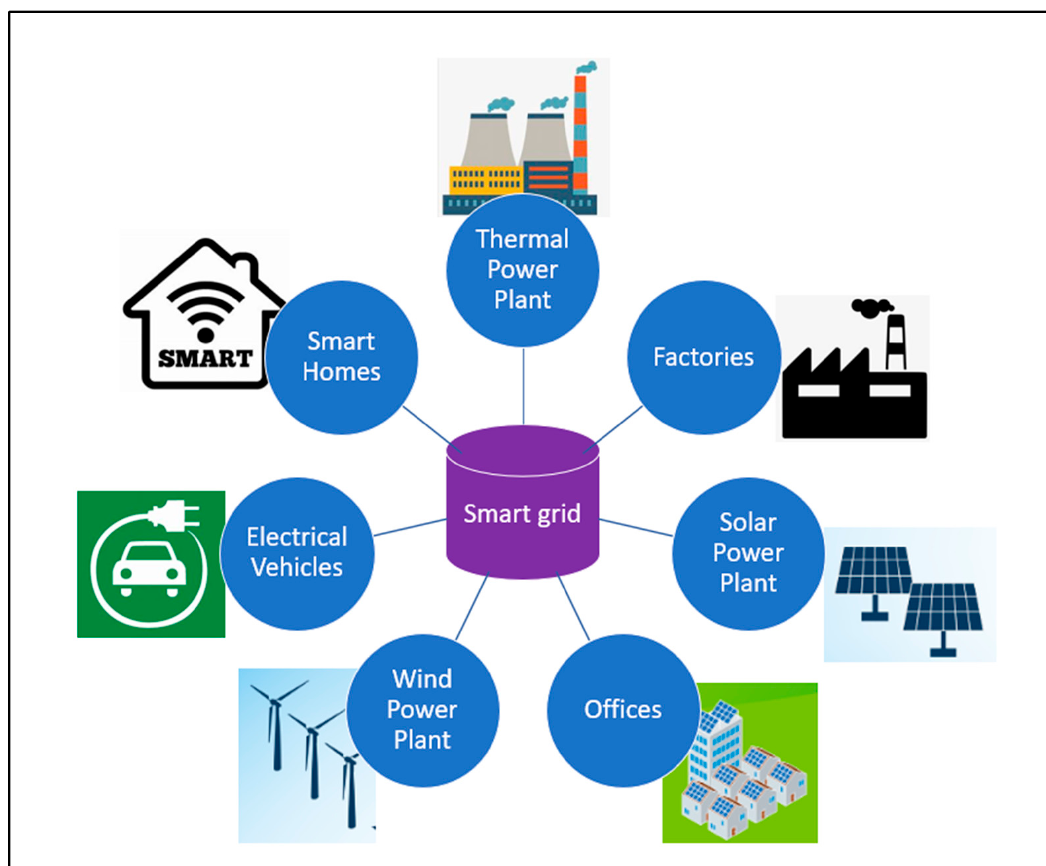
Figure 1. Smart grid diagram.